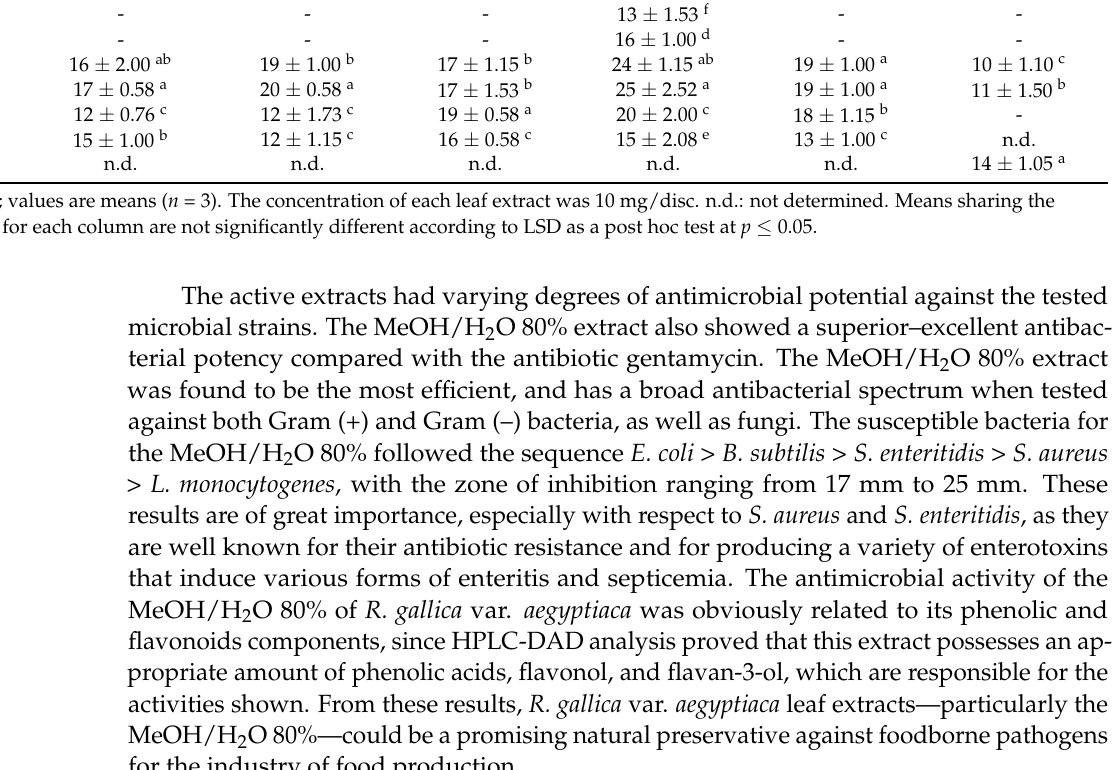
Table 4. Evaluation of in vitro antimicrobial activity of R. gallica var. aegyptiaca leaf extracts. Extract